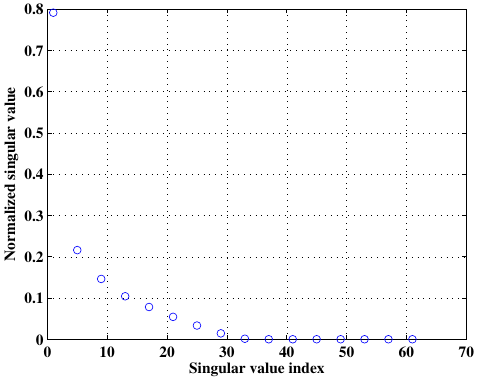
Figure 2. Singular value distribution of simulated ISAR data.